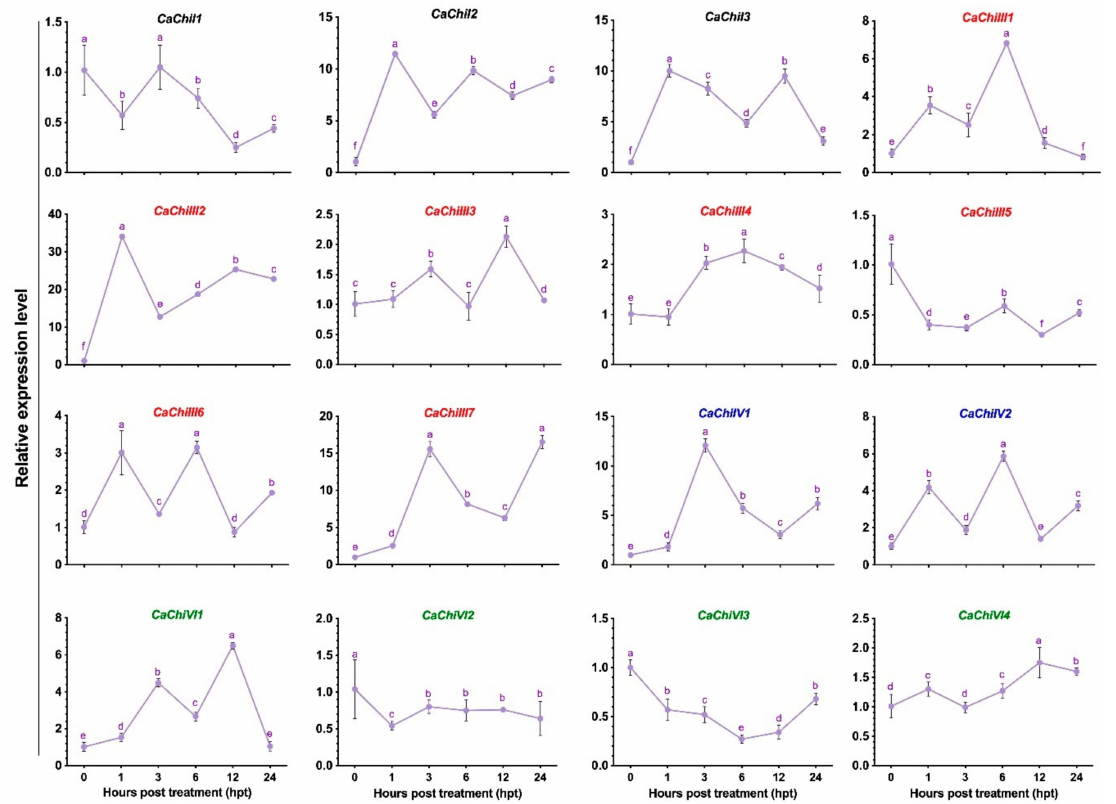
Figure 3. Effect of exogenous melatonin application on the transcription of chitin-binding protein family genes. Tissue sam- ples were taken at different intervals (0, 1, 3, 6, 12, and 24-h post-treatment) and were analyzed through qRT-PCR. The different colors show classes: black: I, red: III, blue: IV, and green: VI. The mean values ± SDs of three replications are given. Lower case letters (a–f) on each line show significant differences at p ≤ 0.05 using the DMR